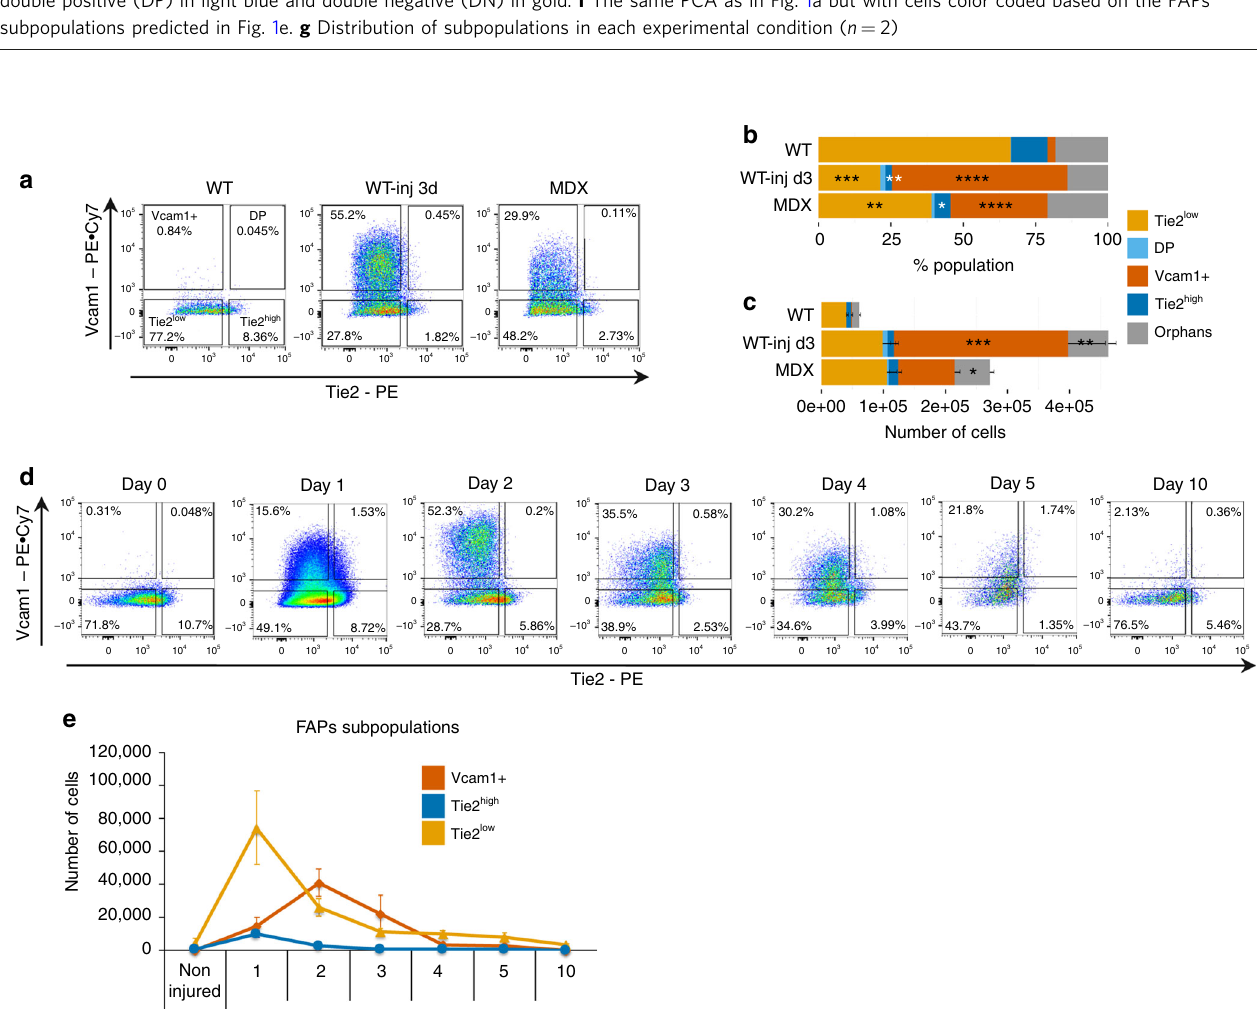
Fig. 1 Heterogeneous FAPs population consists of distinct subpopulations of cells. a Experimental work fl ow for single cell gene expression analysis. Hindlimb muscles of C57Bl/10 mice were isolated, minced, and enzymatically digested. FAPs were isolated by FACS and loaded on the C1 System (Fluidigm) to extract RNA, reverse transcribe RNA to cDNA and pre-amplify cDNA from each single cell. Real-time qPCR analysis of single cell-derived cDNA was performed on the Biomark platform (Fluidigm) for 87 genes. b Principal component analysis (PCA) of single cell gene expression values of FAPs isolated from WT, WT notexin-injured day 3 (WT-inj d3) and dystrophic MDX mice. c Self organizing maps (SOM) representation of gene expression in clusters of single FAP cells. Each circle is a cluster of single cells and the fi ll color represents the level of expression for each gene shown. The expression scale is shown on the left for each gene individually. Expression is measured as Log 2 Ex (Log 2 Ex = Ct (LOD) -Ct (gene) ) with LOD = 24 (limit of detection) and Ct = cycle threshold. d Correlation matrix of single cell gene expression across all cells. Orange color marks high positive correlation, green color marks high negative correlation. Groups of genes outlined in blue are positively correlated, while the genes outlined in green are negatively correlated. e Expression scatterplot of Tek and Vcam1 gene expression. Cutoff is set at 7 Log 2 Ex for both genes based on the SOM graph ( c ). Tek and Vcam1 expression levels de fi ne the predicted subpopulations, marked as Tek(Tie2) + /Vcam − (Tek + ) in dark blue, Vcam1 + /Tek(Tie2) − (Vcam1 + ) in brown, double positive (DP) in light blue and double negative (DN) in gold. f The same PCA as in Fig. 1a but with cells color coded based on the FAPs